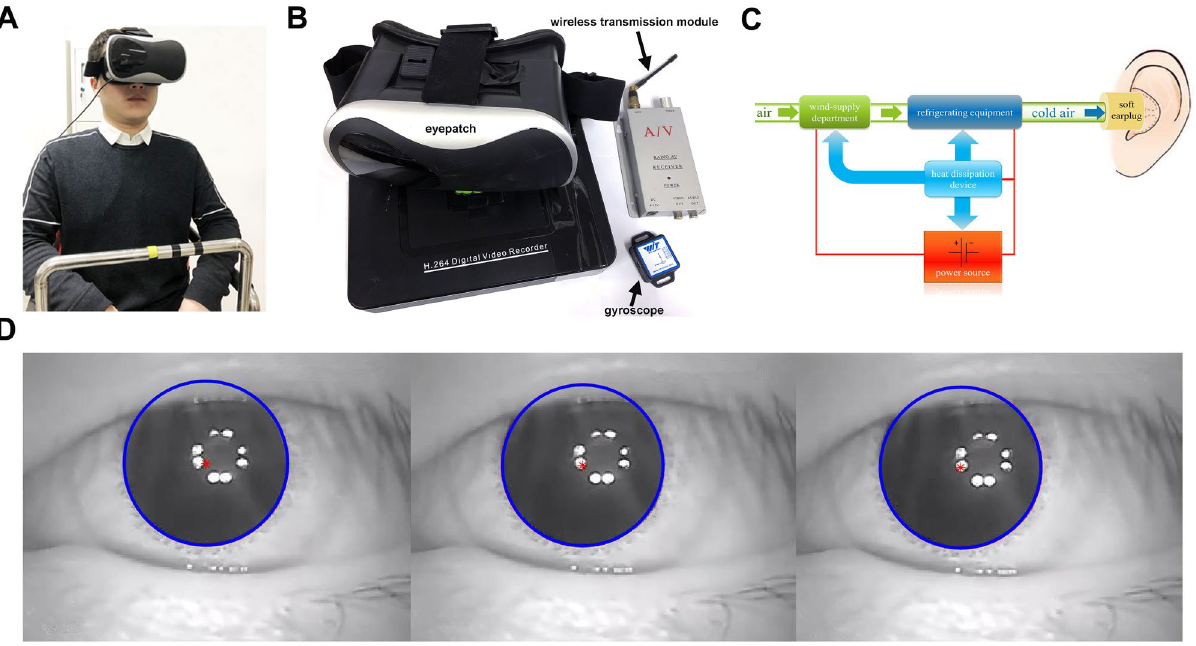
Figure 6. ( A ) The volunteer sitting on the chair. ( B ) The experimental equipment used for recording volunteers’ eye movement. ( C ) Schematic drawing of the refrigerating device for volunteers. ( D ) Locating the center of the pupil in the volunteers’ eye